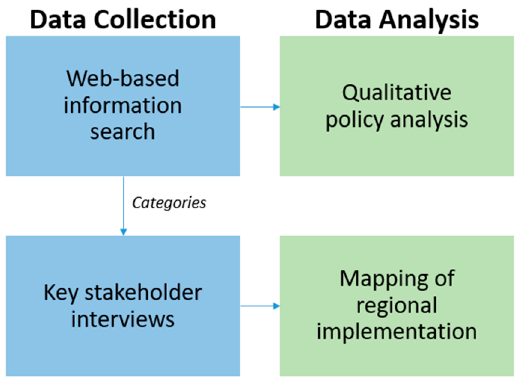
Figure 1. Overview of the Method.